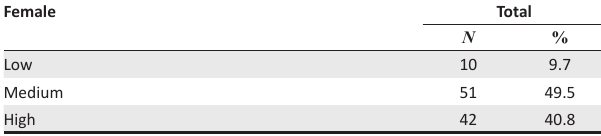
TABLE 1B: Overall strategy usage on the SORS for Botswana female students.